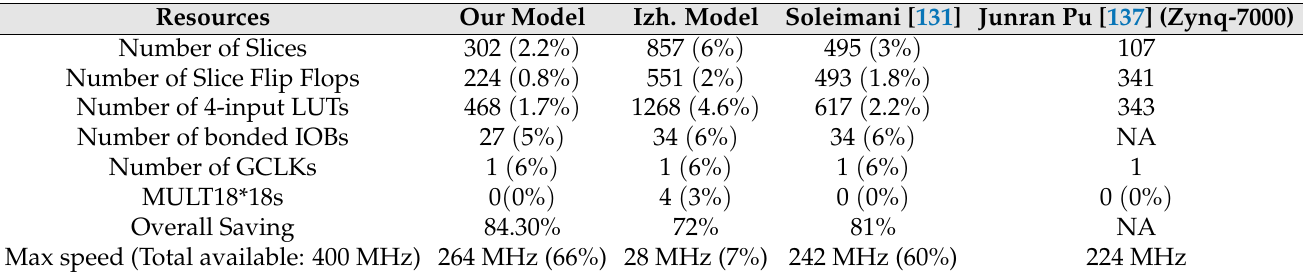
Table 4. Low-level device utilization of XILINX Virtex-II Pro and Zynq-7000; the used percentage of basic elements for implementation of the neuron